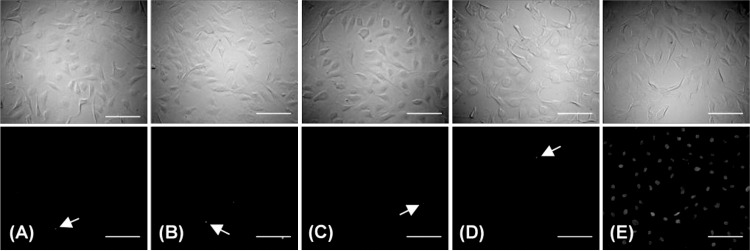
Differential interference contrast (top) and TUNEL stained fluorescent (bottom) images of BAECs.Images of cells immediately following rapid depressurization (A) or slow depressurization (B) after a 3 hr application of elevated hydrostatic pressure along with two negative controls (C: atmospheric pressure and D: atmospheric pressure without using terminal transferase) and one positive control (E: DNase recombinant I). White arrows indicate locations of TUNEL staining, a few of which were seen in panels A-D; panel E shows that nearly all of the positive control cells were apoptotic. The images represent data gathered from two replicates per experimental group. Scale bar = 100 μm.